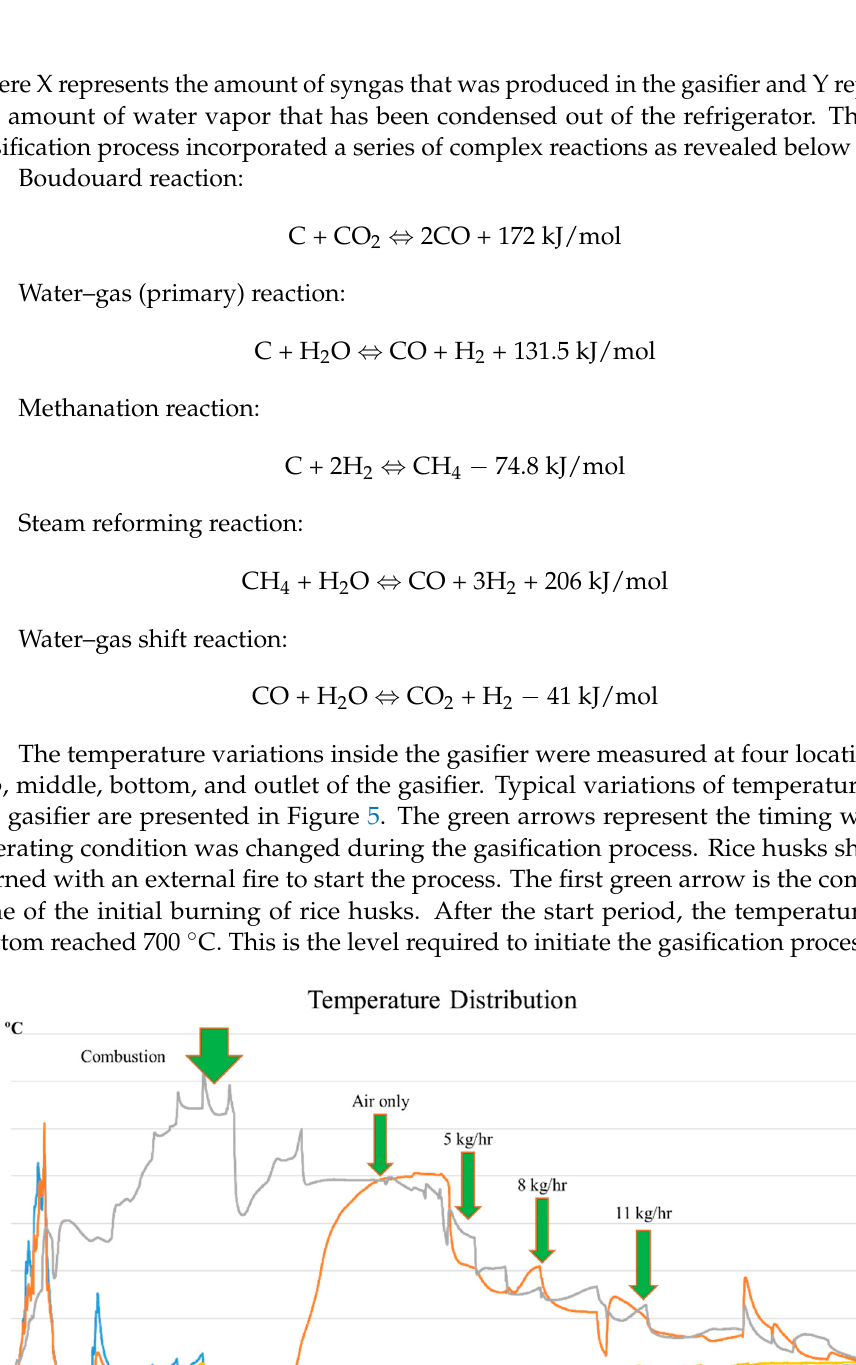
perature inside the gasifier dropped immediately as new rice husks covered the old